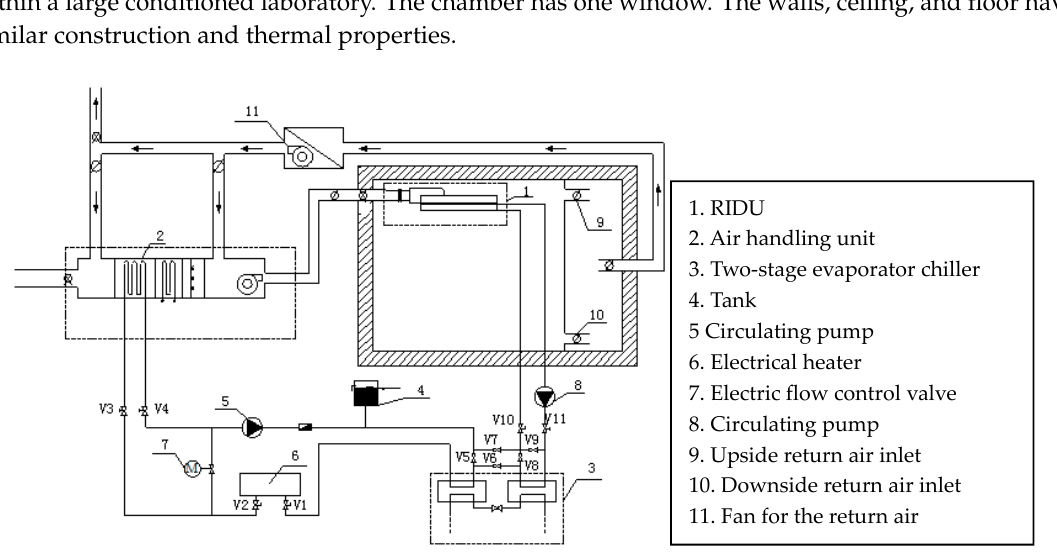
Figure 1. The experimental system. RIDU: Radiant induction-unit.